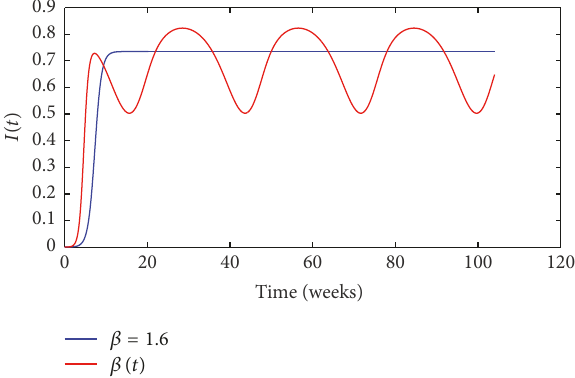
Figure 5: Variation of the infected fraction with the constant infection rate, 𝛽 (in blue), and the seasonal infection rate, 𝛽(𝑡) (in red), defined in (4). Here 𝛽 0 = 1.66 and 𝜔 = 0.28 .